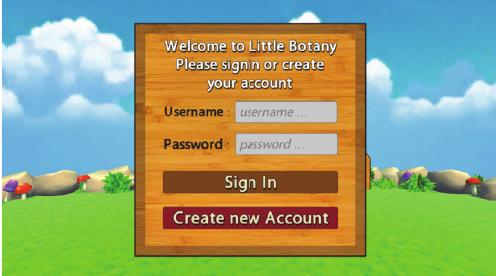
Figure 9: User login or register scene.